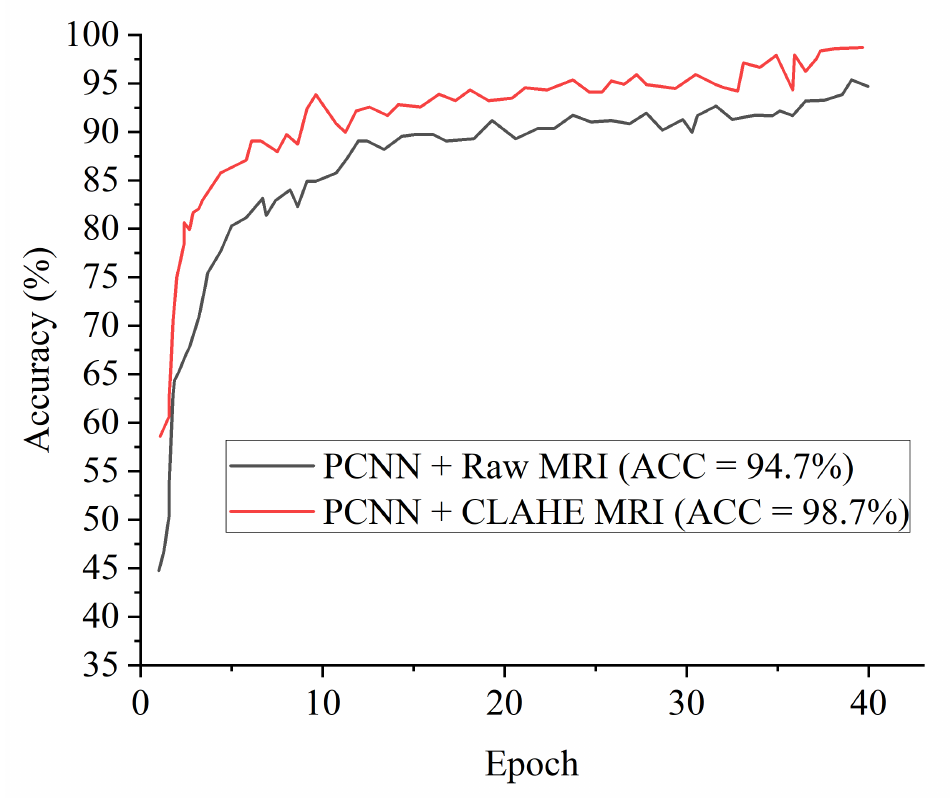
Figure 5. Accuracy curves for the proposed PCNN in comparison with raw MRI images and CLAHE pre-processed MRI